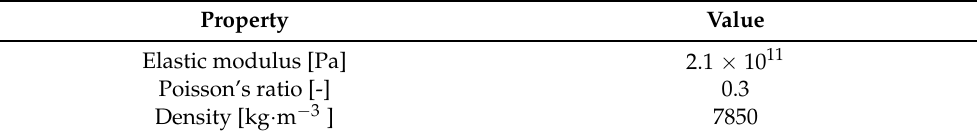
Figure 10. CAD model and boundary conditions of the stationary structures of the PT unit. Table 2. Material properties of the studied